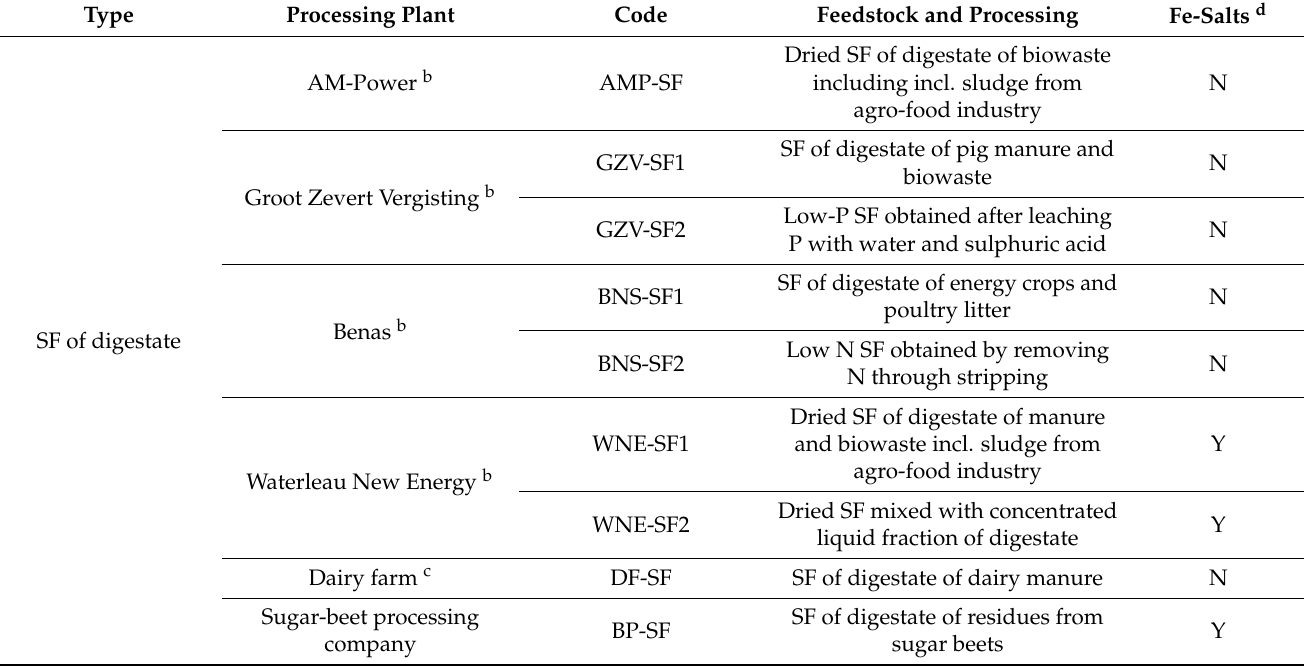
Table 1. Origin of the solid organic fertilisers, feedstock and description of feedstock processing a . Type Processing Plant Code Feedstock and